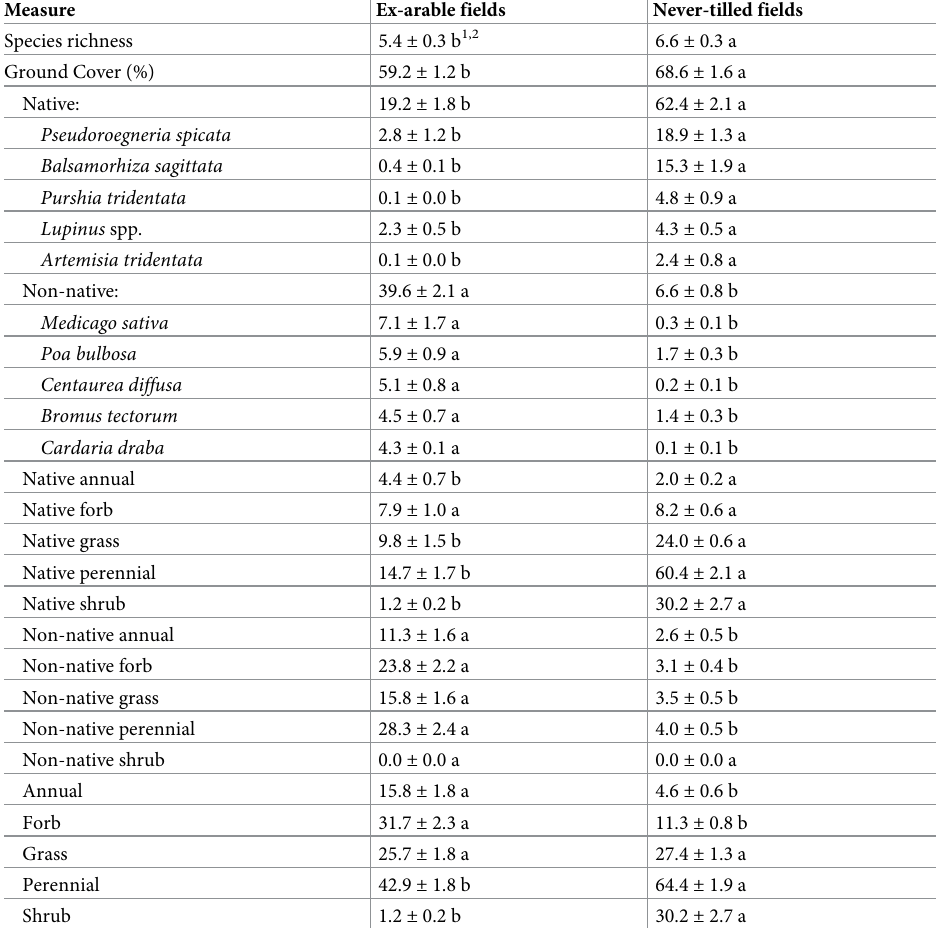
Table 1. Mean cover of dominant plant species and functional groups and several community traits in adjacent ex-arable and never-tilled fields, Methow Valley, Washington, USA. Cover values within fields (replicate plots) and among years were averaged prior to calculations so that values represent averages and standard errors associated with the 25 fields.